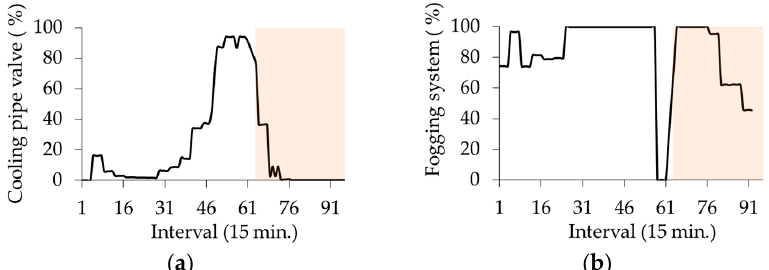
Figure 15. Environmental control of a building microgrid with rooftop greenhouse: ( a ) Temperature; ( b ) Humidity.